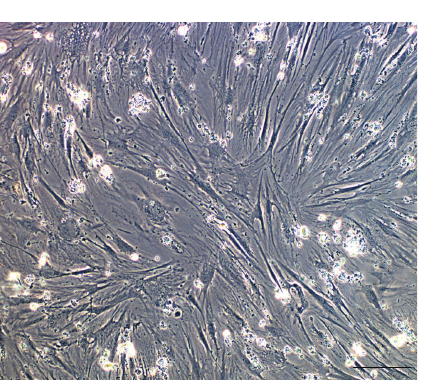
Figure 14: Sphere formation assay on OSA3-CSCs after 30 days. After 30 days big spherical colonies can be observed. Observation